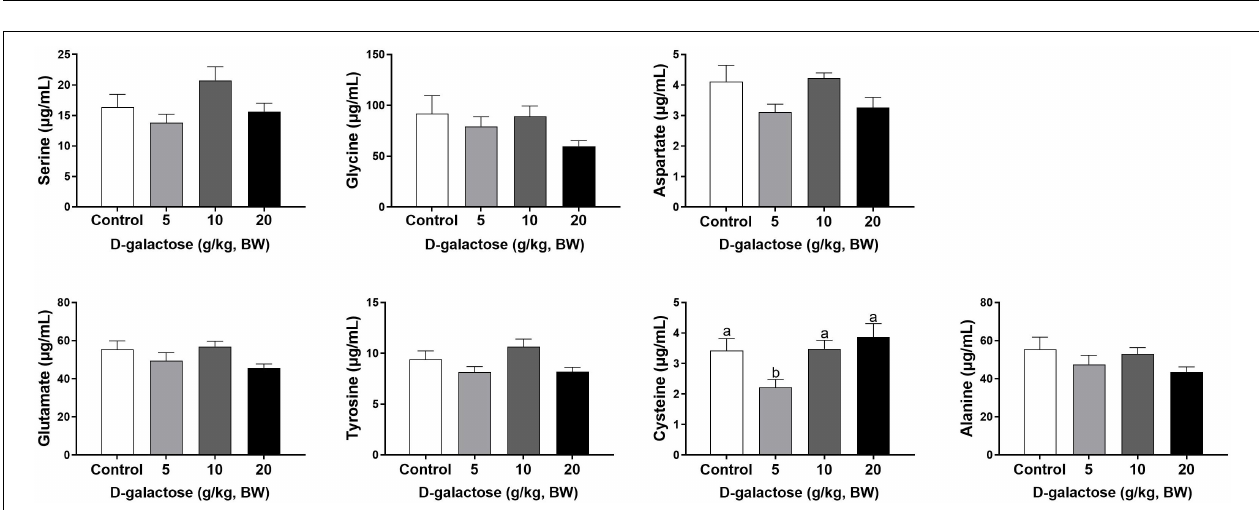
FIGURE 6 | Effects of D -galactose on essential amino acids in the serum at the second week. Data were expressed as the mean ± SEM. Different lower-case letters indicate a significant difference among different dosage of D -galactose ( P < 0.05).